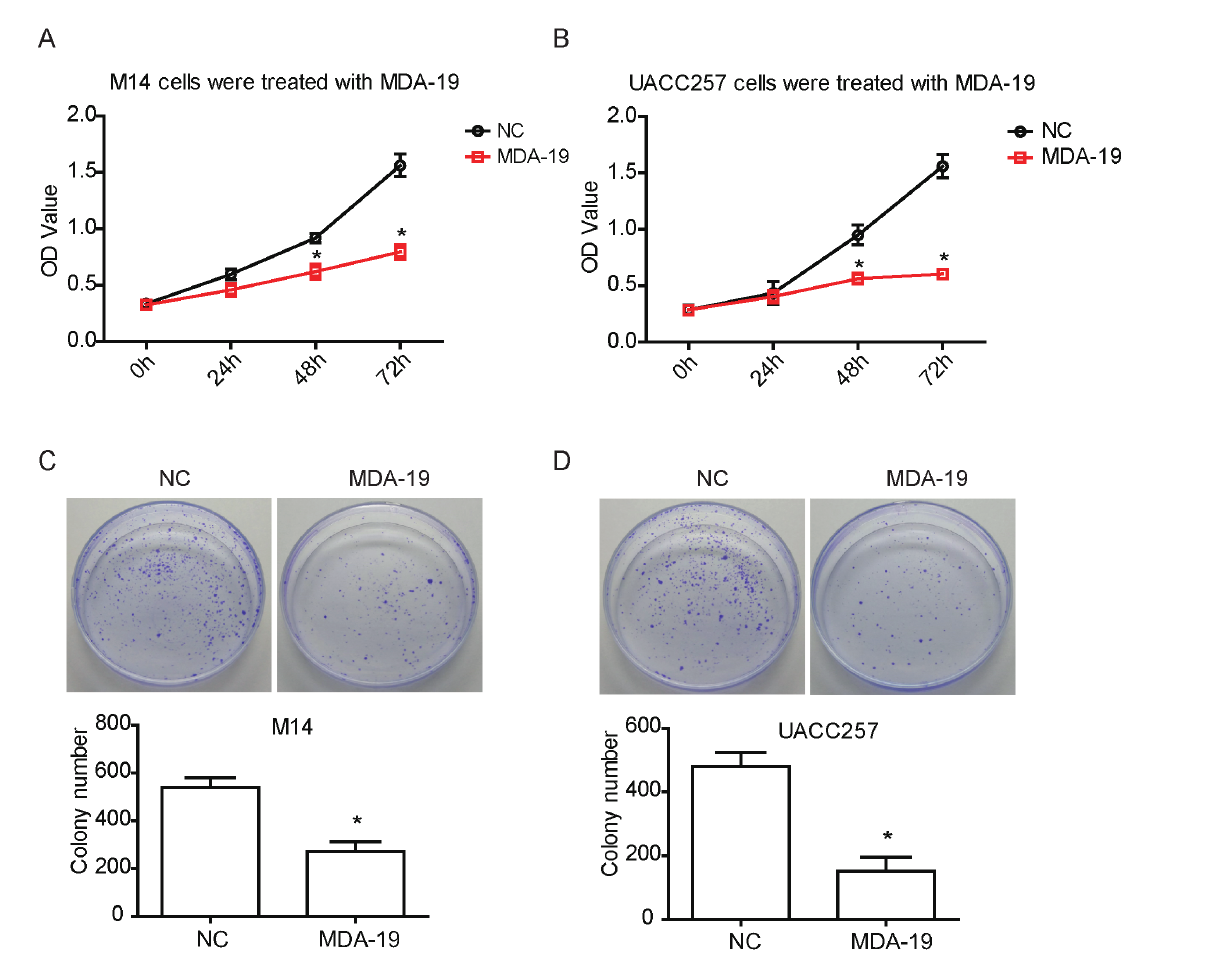
Figure 2: MDA-19 inhibits the viability and proliferation of melanoma cells in vitro. M14 cells was treated with 20 μM of MDA-19, and UACC257 cells was treated with 10 μM of MDA-19. (A) (B) M14 cell (A) and UACC257 cell (B) were treated with MDA-19 for 0, 24, 48, 72 h, and the absorbance was detected using CCK8 kit. (C) (D) M14 cell (C) and UACC257 cell (D) were treated with MDA-19 for colony formation assay. Data are expressed as the mean ± SD. MDA-19: MDA-19 treated group; NC: DMSO treated group, negative control.